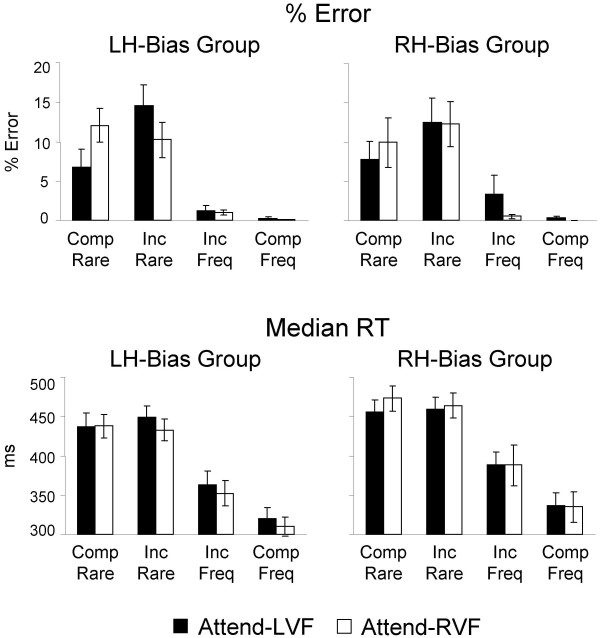
Behavioral performance data. Error rate and median RT data for each hemispheric utilization bias group. Bars indicate standard error. Comp = Compatible, Inc = Incompatible.